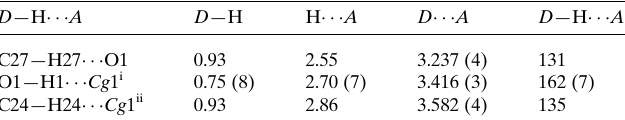
Figure 5 The crystal packing of compound I , viewed along the a -axis, showing the supramolecular ribbons formed by intermolecular C—H (cid:2)(cid:2)(cid:2) (cid:2) interactions (Table 1; shown as dashed purple lines). Only hydrogen atoms H20 and H24 are shown for clarity.